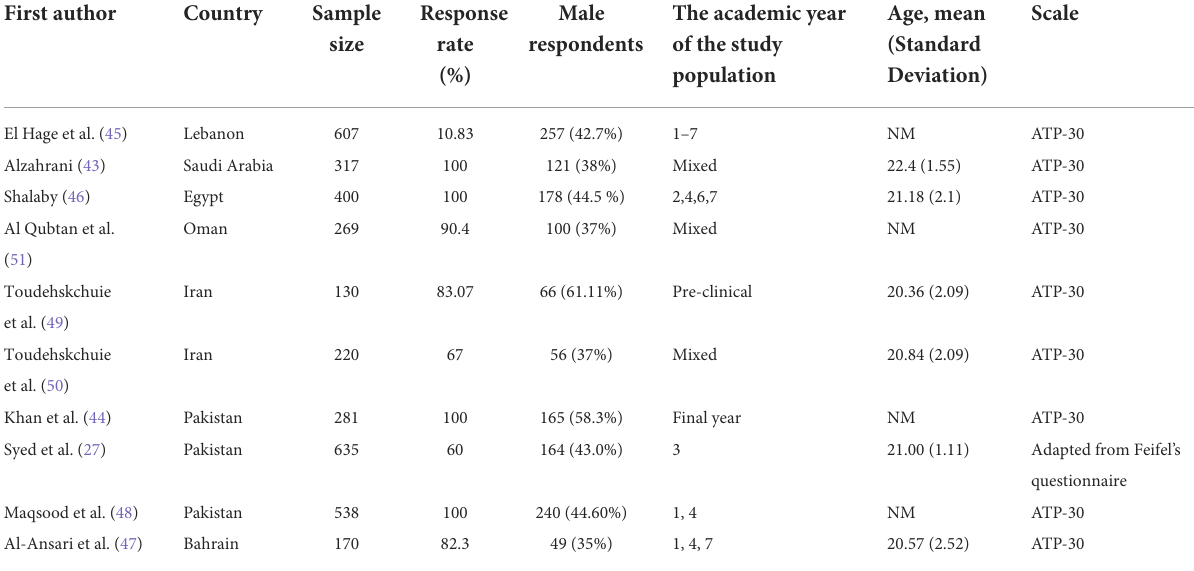
TABLE 1 The general characteristics of the included articles in the review of studies assessing the stigma toward psychiatry among medical students in the Eastern Mediterranean